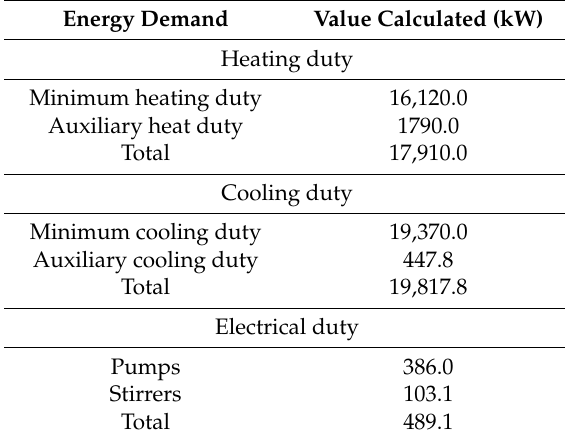
Table 3. External energy duty requirements of the simulated biorefinery